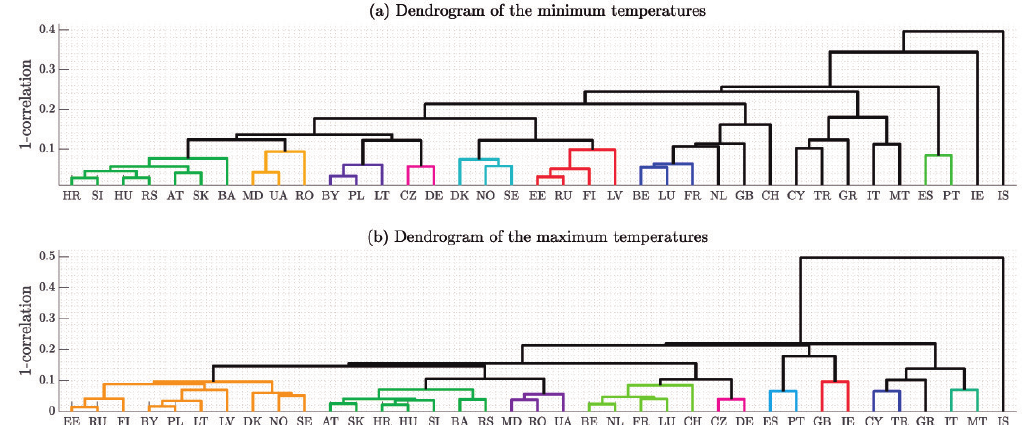
Figure 7. Dendrograms of the 37 European weather stations, based on the ( a ) minimum and ( b ) maximum temperatures. The coloured clusters correspond to those formed using a correlation threshold of